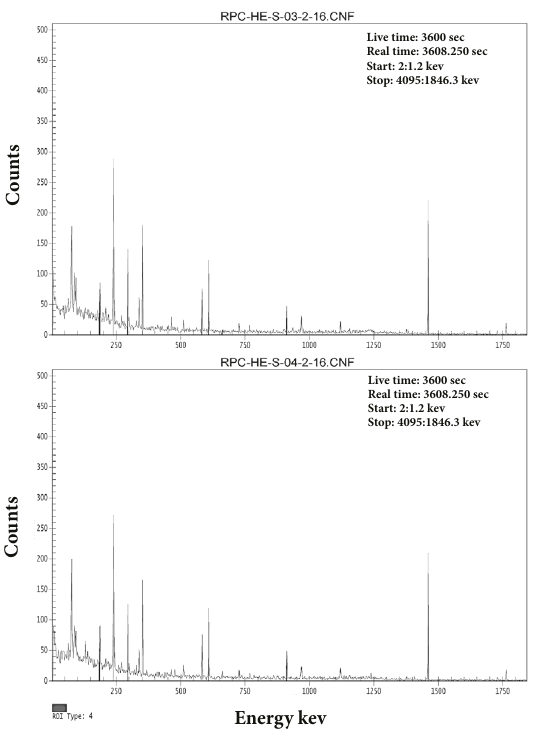
Figure 4: Same as Figure 3 for samples 3 and